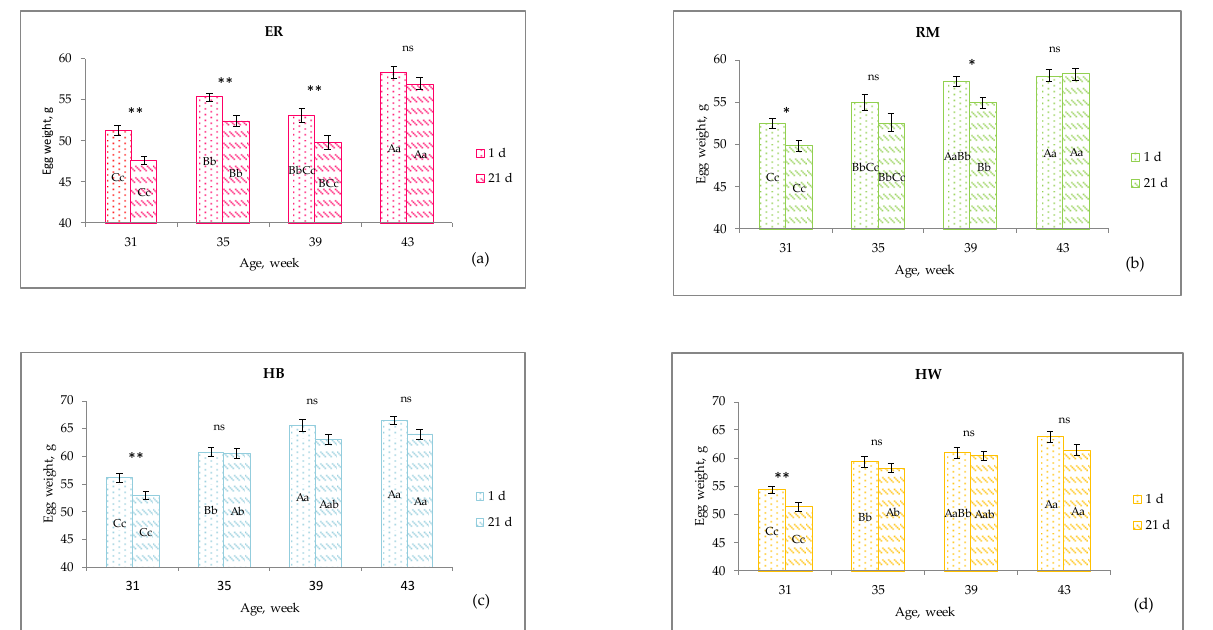
Figure 2. Effect of age on the weight of 1 d egg (lsmeans ± SE) and stored 21 d eggs (lsmeans ± SE) of each genotype 1 . Different letters among similar columns (storage time) indicate different values. a, b, c: p < 0.05; A, B, C: p < 0.01. *: p < 0.05 and **: p < 0.01 indicate different values between columns of different storage time per each age. ns: no significance. 1 Genotype: ER: Ermellinata di Rovigo ( a ); RM: Robusta maculata ( b ); HB: Hy-line brown ( c ); HW: Hy-line white ( d ). Observations ( n ) per age (at 1 d; at 21 d): ER (30, 30, 24, 30; 30, 24, 18, 20), RM (25, 22, 22, 24; 20, 16, 20, 20), HB (30, 30, 24, 30; 29, 25, 25, 25), HW (30, 30, 24, 30; 28, 24, 24, 24).